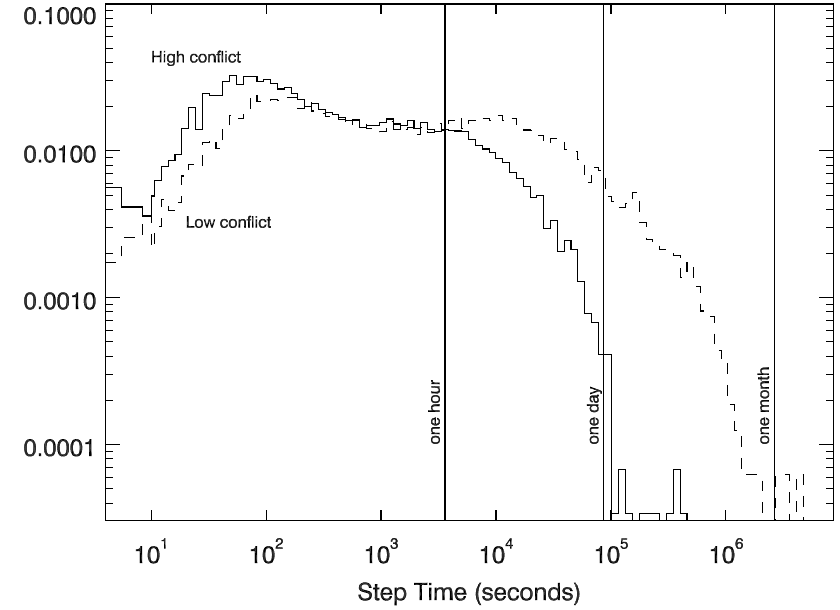
Figure 3. Distribution of edit rates for type one (high conflict) and type two (low conflict) subspaces. Shown here, as an example, is the spacing between edits on the George W. Bush page. When the system is in the high-conflict subspace, edits occur once every 212 s (median; 3.5 min); in the low-conflict subspace, once every 951 s, or every 16 min. When the system is in the high-conflict subspace, users almost never wait more than a day to take